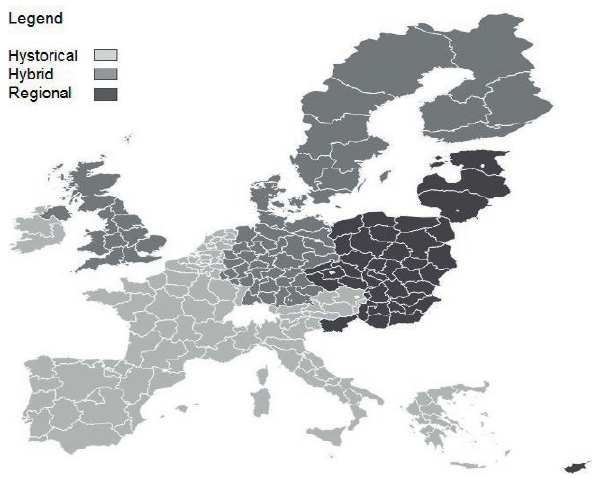
Figure 1. EU regions adopting different implementation schemes of the CAP 2003